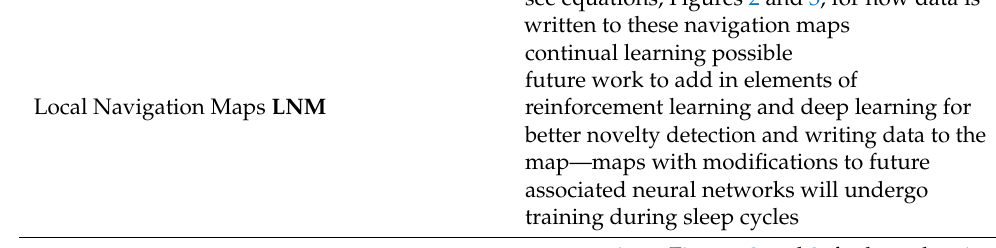
Local Navigation Maps